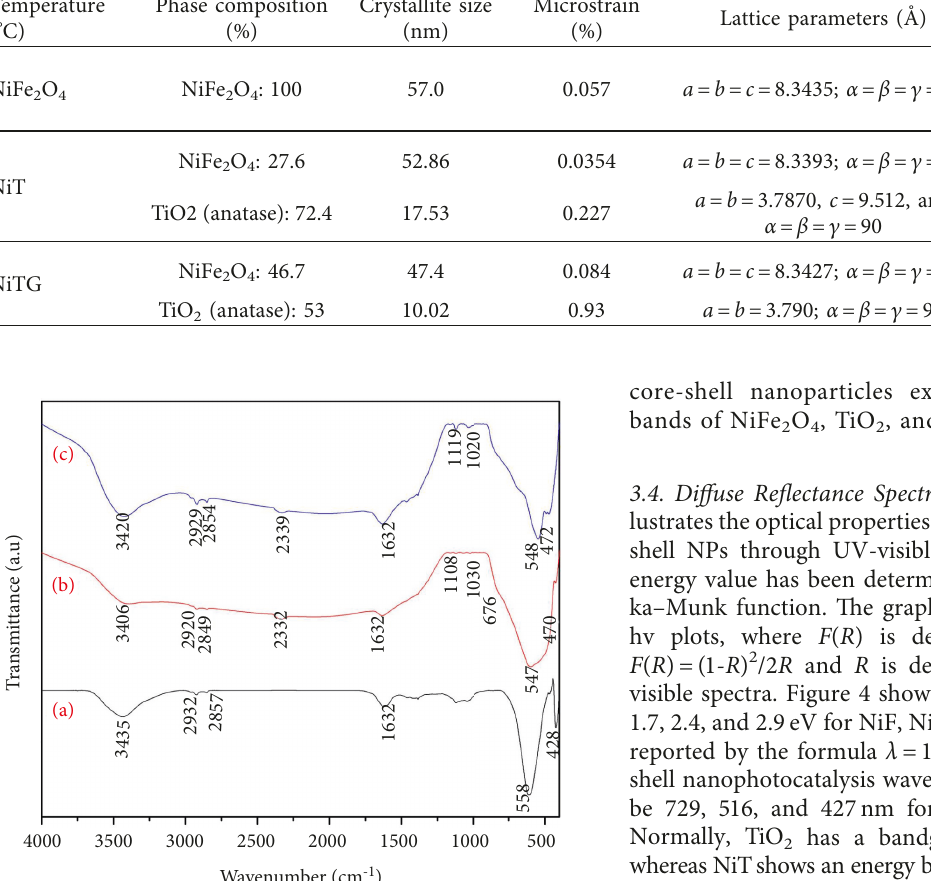
Table 1: Crystallite size, lattice parameter, and fit parameter of (a) Ni; (b) NiT; (c) NiTG. Temperature